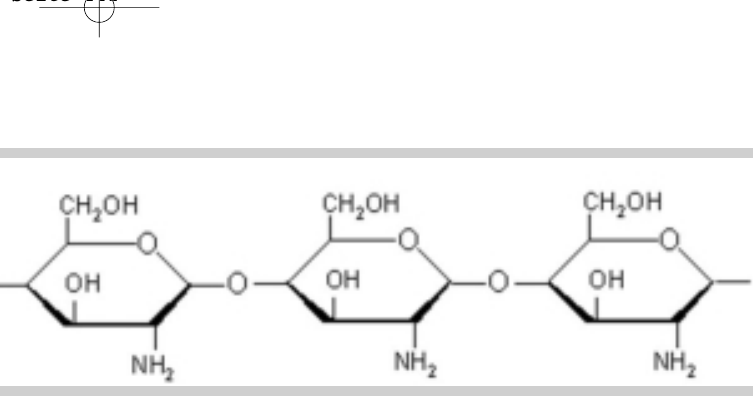
Figure 1: Chitosan partial